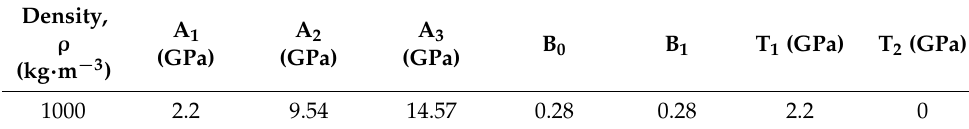
Table 2. Polynomial EOS of water [35].